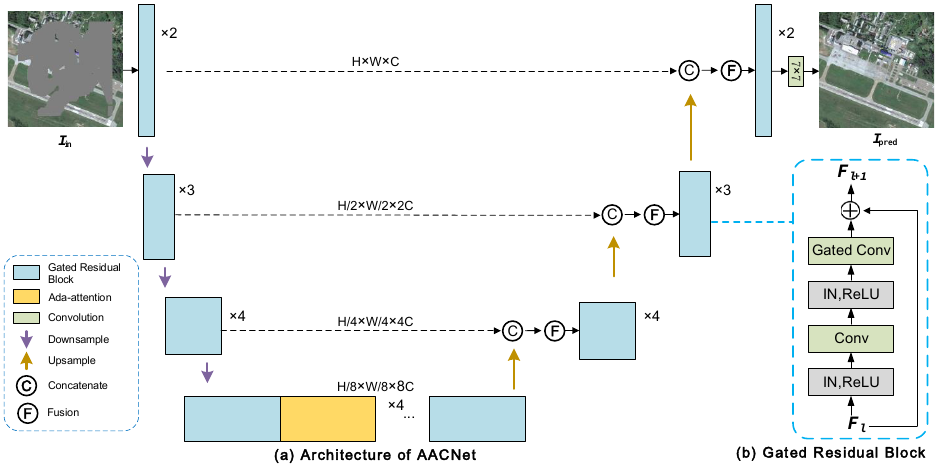
Figure 2. ( a ) The architecture of our Adaptive-attention Completing Network (AACNet). ( b ) The architecture of gated residual block. Our network consists of four pyramid stages for the encoder and decoder. Stages 1–3 include several gated residual blocks, and the fourth stage supplements several Ada-attention modules to improve the long-range modeling ability. The AACNet uses upsampling or downsampling module to change the feature map size and channel number between two adjacent